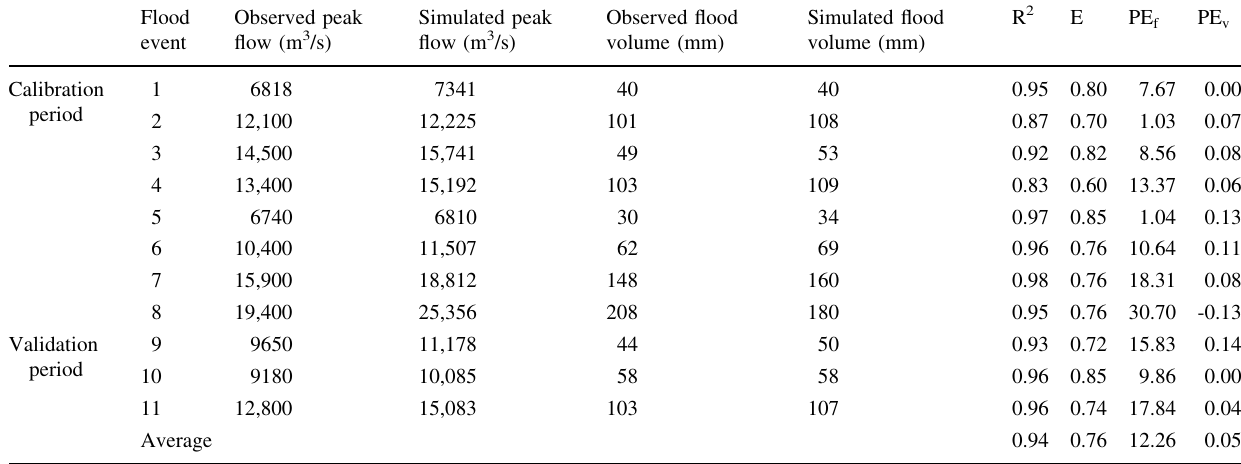
Fig. 2 Comparison of observed and simulated hydrographs for 11 flood events in the Xiang River Basin Table 3 Summary of peak flood flow and flood volume for 11 flood events during the calibration (2007–2010) and validation (2011–2012) periods in the Xiang River